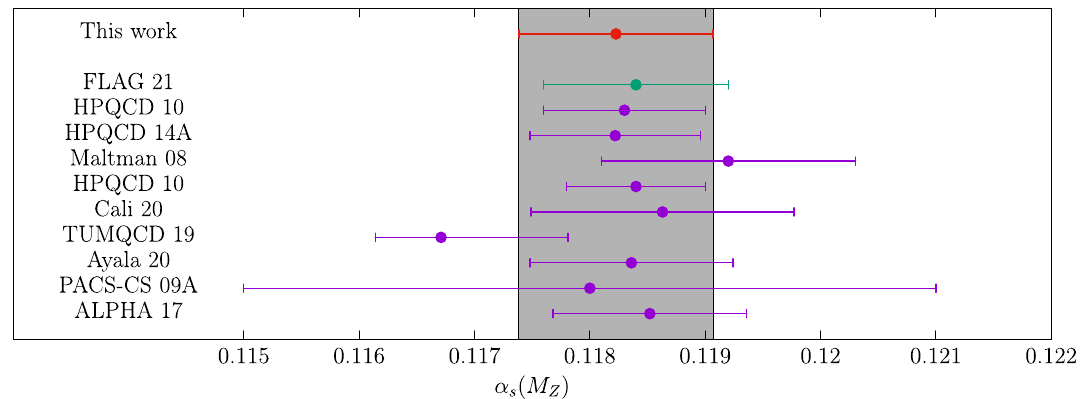
Fig. 4 Our result compared with other lattice computations [16,17,70,81–84] that enter in the FLAG average [4] (acronyms taken from the FLAG report [4])